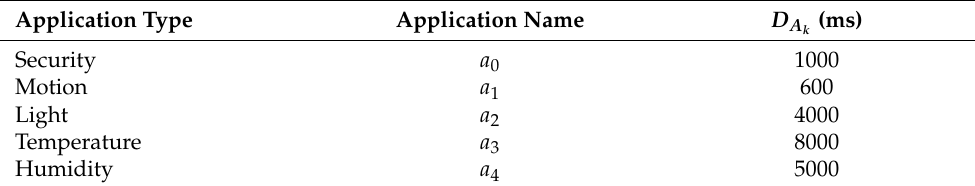
Figure 4. The mapping of different parts of smart home use-case within the iFogSim environment. Table 3. Application deadlines after a 2-week period experiment.